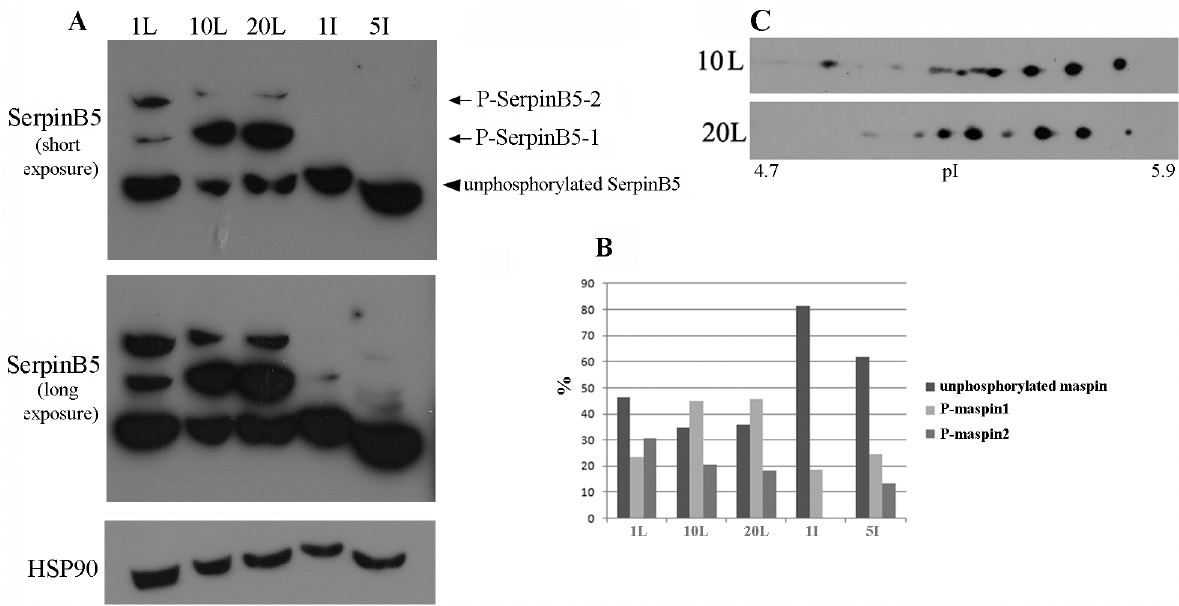
Fig 2. SerpinB5 phosphorylation in the lactating mammary gland. A. 100 ug of protein extracts from mammary gland isolated on days 1, 10 and 20 of lactation (1L, 10L and 20L), and on days 1 and 5 of involution (1I and 5I) were resolved by 8% Phos-Tag ™ SDS-PAGE gel. Proteins were transferred to PVDF membrane and probed with rabbit anti-SerpinB5 (Sigma). Arrows indicate two phosphorylated SerpinB5 bands (P- SerpinB5-1 and P- SerpinB5-2) and arrowhead indicates unphosphorylated SerpinB5. Top and middle panels represent a short and a long X-ray film exposure, respectively. The membrane was reincubated with anti-HSP90 for a loading control; B. each of the three bands was quantified and expressed as percentage of the total levels of detected SerpinB5. This result is representative of two independent experiments; C. 2 mg of protein extracts of mammary gland isolated on days 10 and 20 of lactation were analyzed by 2D-SDS-PAGE using 17 cm pH 4.7 – 5.9 IPG strips followed by Western blot with anti-SerpinB5 (Santa Cruz). This result is representative of two independent